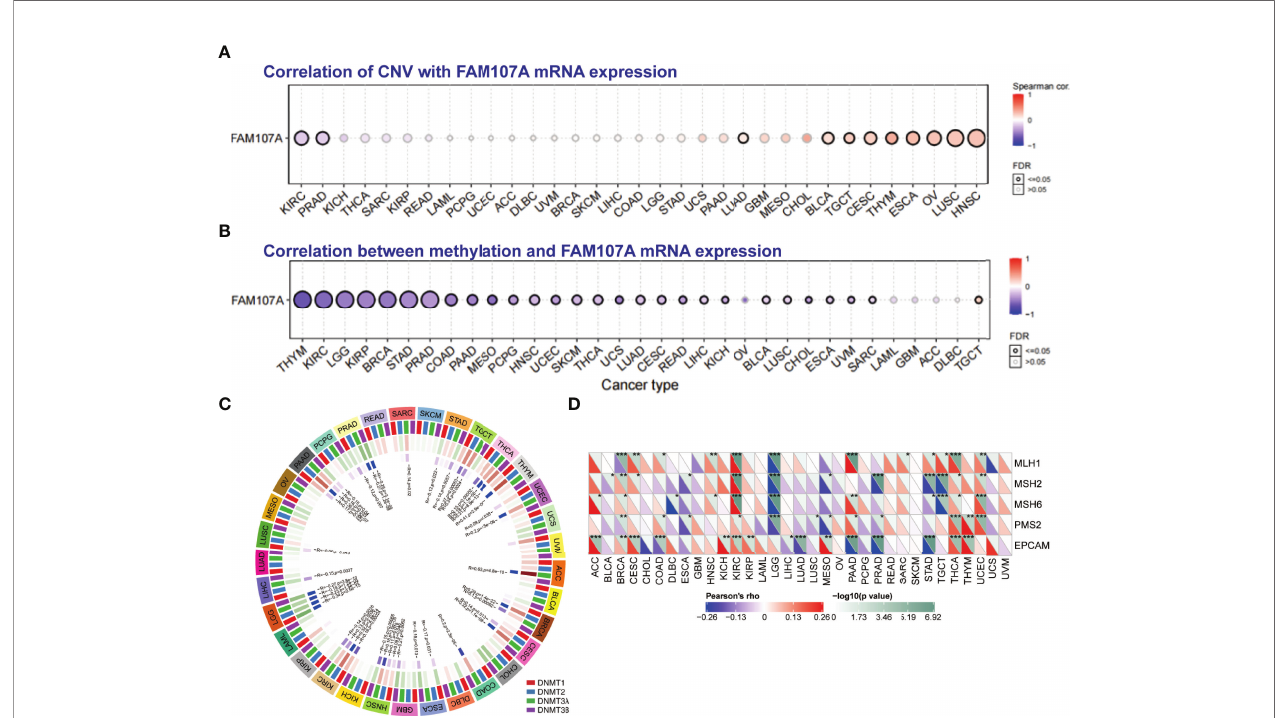
FIGURE 4 | The correlation between FAM107A expression and CNV, DNA methylation and mutation levels of MMR genes. (A) The correlation between CNV and expression of FAM107A mRNA was analyzed. Blue dots indicate negative correlation and red dots indicate positive correlation between CNV and FAM107A expression. The darker color represents the higher correlation. The larger size of the point represents the greater signi fi cance. (B) The correlation between methylation level and expression of FAM107A mRNA was analyzed by the GSCA database. Blue dots indicate negative correlation and red dots indicate positive correlation between methylation and FAM107A expression. The darker color represents the higher correlation. The larger size of the point represents the greater signi fi cance. (C) The correlation between FAM107A expression and the expression levels offour methyltransferases was displayed. (D) The correlation between FAM107A mRNA expression and mutation levels of fi ve key MMR genes (MLH1, MSH2, MSH6, PMS2, EPCAM) was analyzed based on TCGA data. The upper triangle in each tile indicates log10 transformed P-value, and the lower triangle indicates coef fi cients calculated by Pearson ’ s correlation test. *P < 0.05; **P < 0.01; ***P <